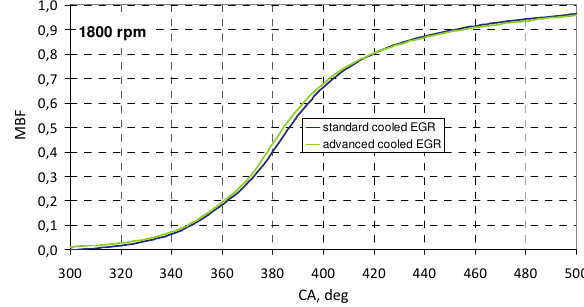
Fig. 20. Impact of EGR cooling system at differential pressure Pd (engine rotational speed: 1400 rpm, 190 Nm load)